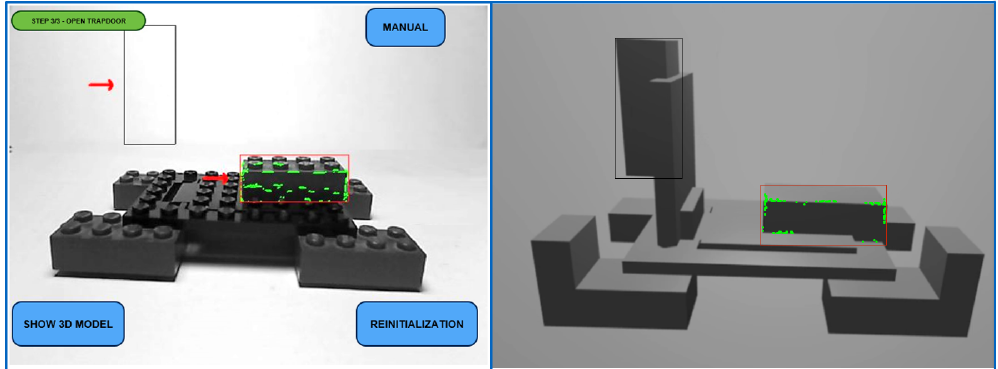
Figure 16. Starting position (red bounding box) and final position (black bounding box) for the given step, on the real object ( left ) and the virtual model ( right ).